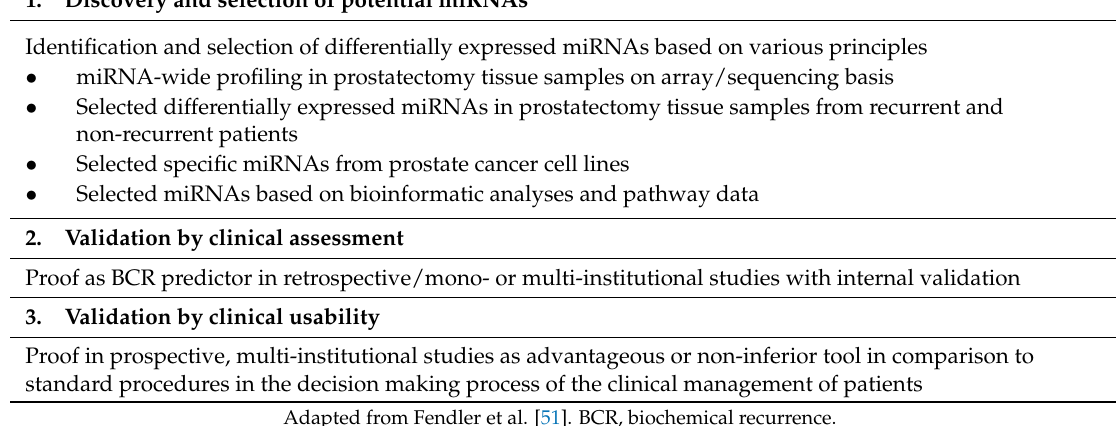
radical prostatectomy.